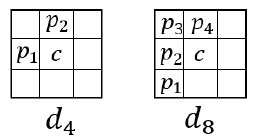
Figure 5. d 4 and d 8 metrics for the first